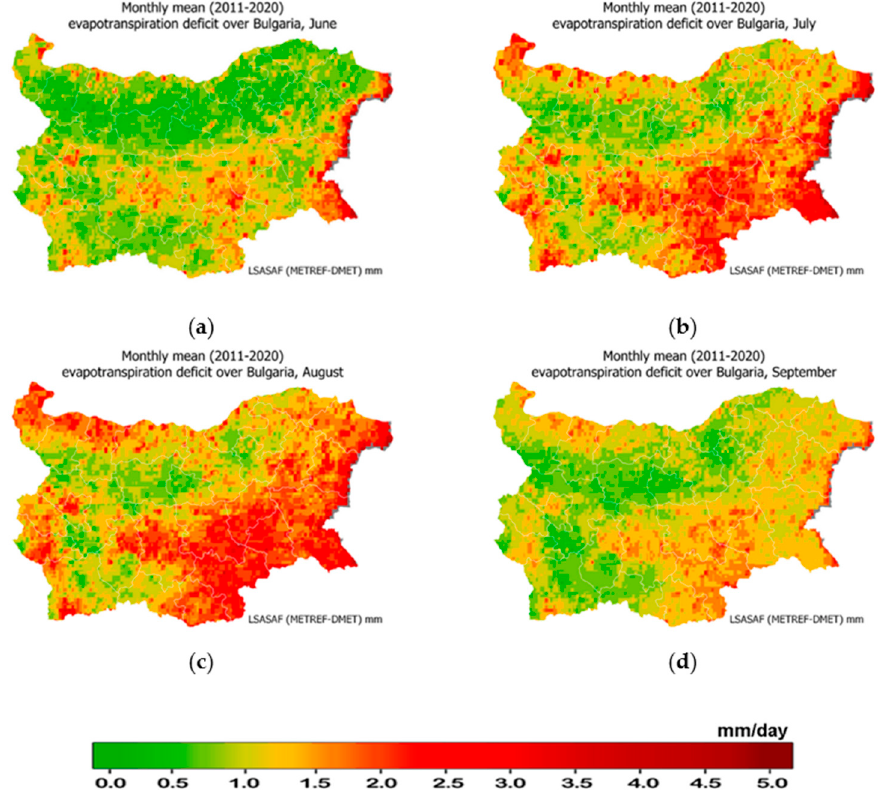
Figure 4. Spatiotemporal distribution of the seasonal evapotranspiration deficit over Bulgaria con- structed on the basis of LSASAF METREF and DMET products. Color-coded maps show monthly means (2011–2020) for: ( a ) June; ( b ) July; ( c ) August; ( d ) September.